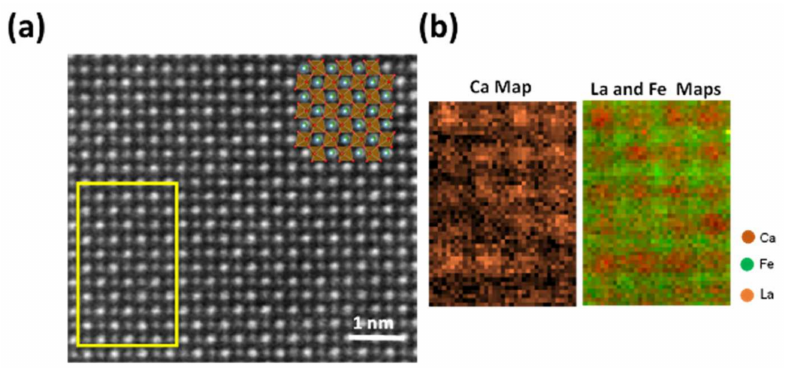
Figure 8. ( a ) Experimental HAADF-STEM image of a crystal of LCFCr along the [010] zone axis and ( b ) the EELS maps of the yellow area of Ca atoms indicated in brown, La atoms in orange, and Fe atoms in